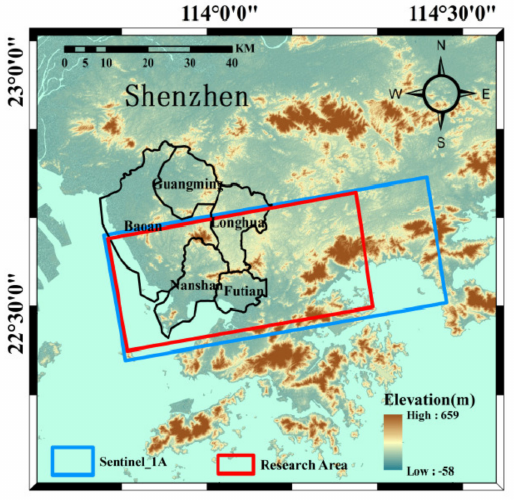
Figure 7. Overview of the research area and coverage of SAR datasets.